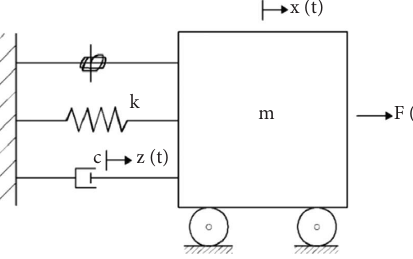
Figure 1: BWBN model